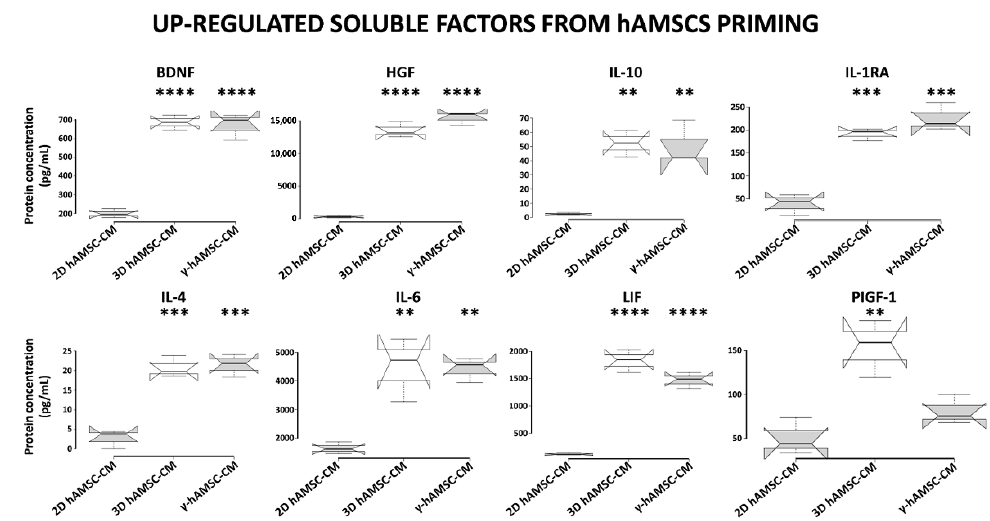
Figure 6. Secretion of functional factors in conditioned medium (CM) derived from two-dimensional (2D hAMSC-CM), three-dimensional (3D hAMSC-CM) and IFN- γ -treated ( γ -hAMSC-CM) hAMSC cultures. The CM was collected after 48 h of culture. The concentrations of each factor were determined by multiplex-microbead immunoassay. Box plots of three independent experiments are displayed, where the horizontal bar represents the median, the box represents the interquartile range (IQR) and the whiskers represent the maximum and minimum values. Comparisons made by Dunnet’s t -tests. ** = p < 0.005; *** = p < 0.0005; **** = p < 0.0001 compared with 2D hAMSC-CM.